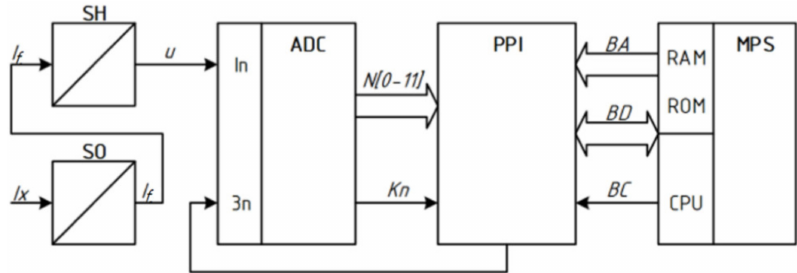
Figure 1. Generalized block diagram of the measuring